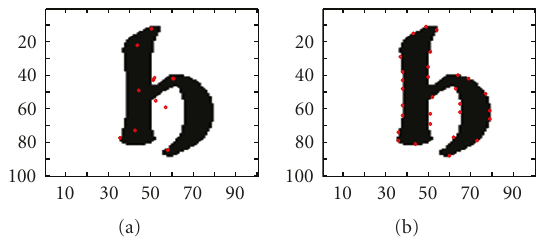
Figure 16: Interest points detected from the binary image of letter “h” by (a) the SIFT algorithm and (b) the proposed algorithm.